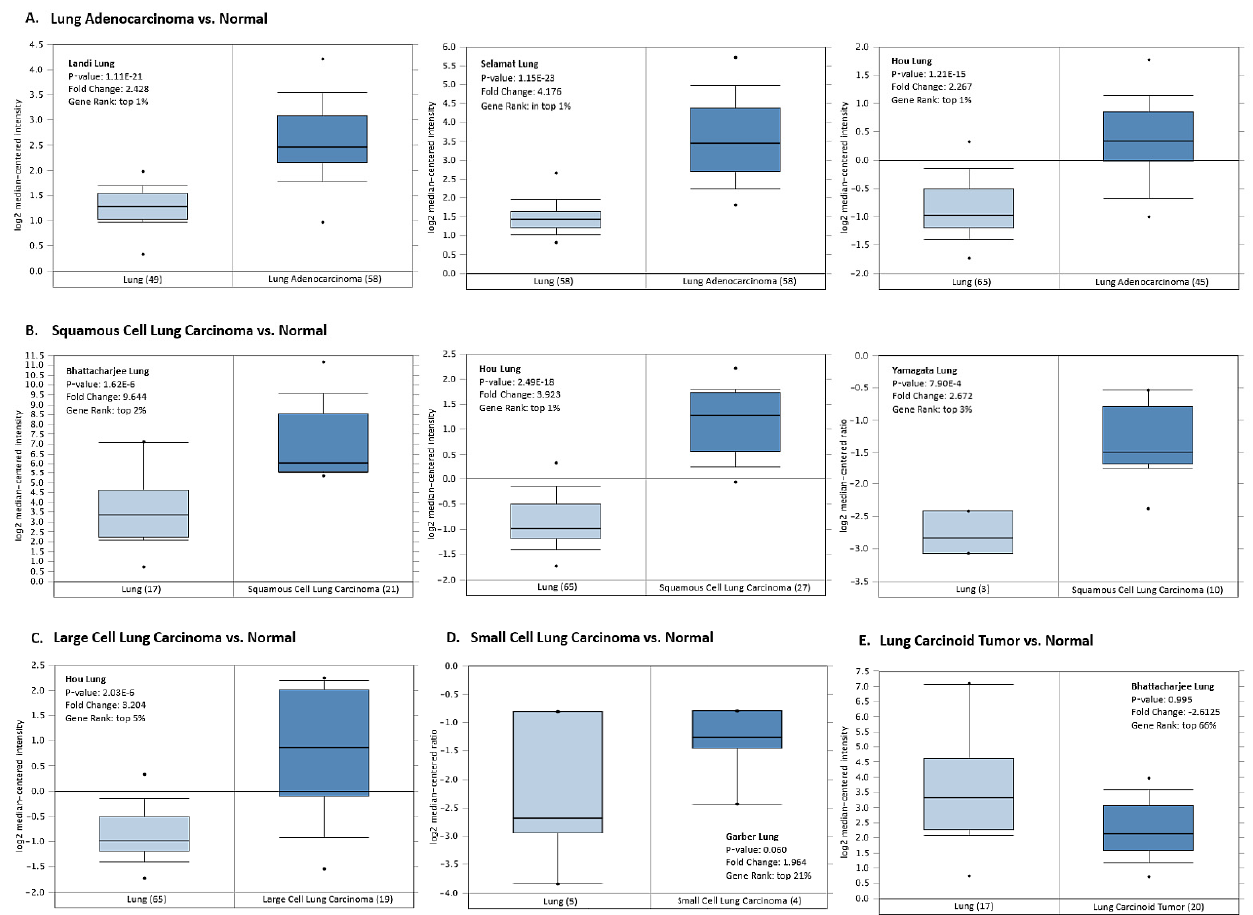
Figure 6. HMGA1 expression level in normal lung tissue and different histological subtypes of lung neoplasm by Oncomine platform. The analysis is shown for ( A ) lung adenocarcinoma (Landi Lung, Selemat Lung, Hou Lung), ( B ) squamous cell lung carcinoma (Bhattecharjee Lung, Hou Lung, Yamagata Lung), ( C ) large cell lung carcinoma (Hou Lung), ( D ) small cell lung carcinoma (Garber Lung), and ( E ) lung carcinoid tumor (Yamagata Lung).